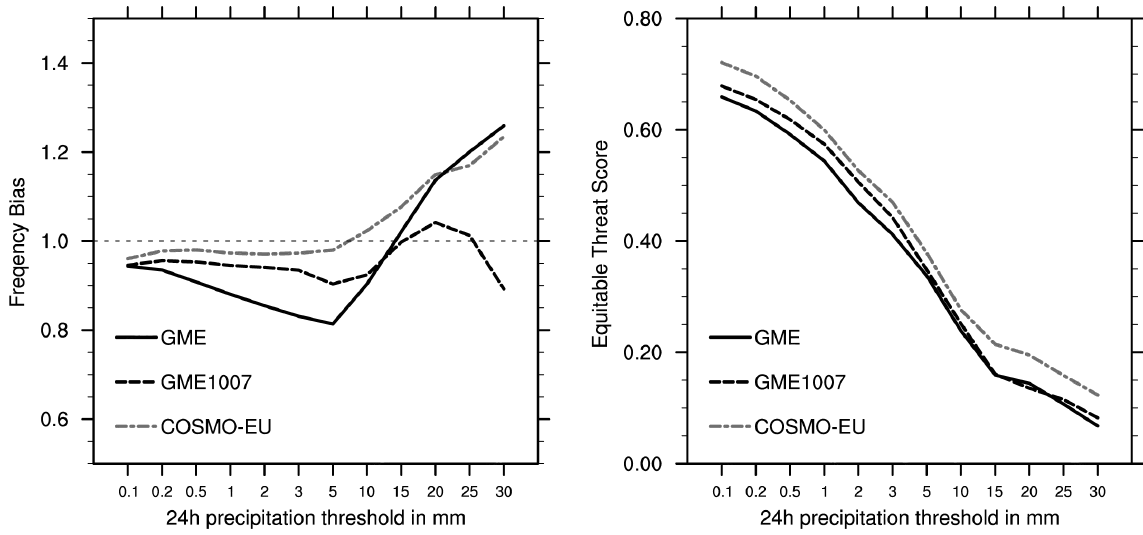
Fig. 1. Frequency bias (left) and equitable threat score (right) of 24h accumulated precipitation. Model results are verified against a gridded precipitation data set for Germany based on more than 600 rain gauges from 1 July 2009 to 31 October 2009.